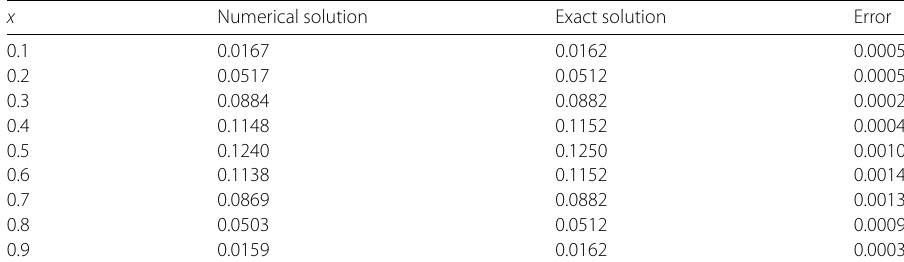
Figure 4 The solution behavior of (17) at t = 0.25, t = 0.75, t =